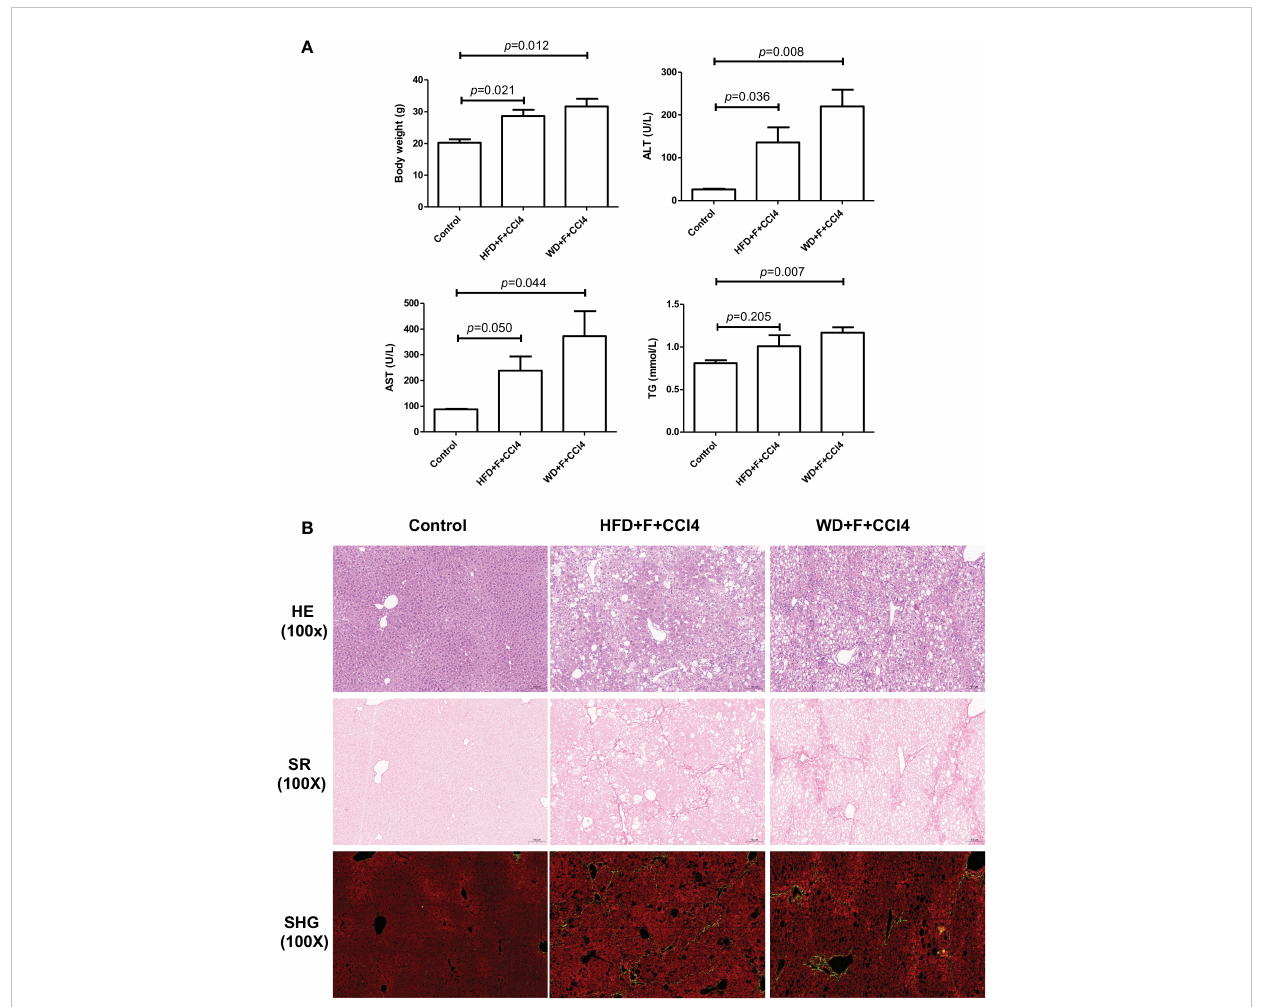
FIGURE 1 Metabolic and pathological characteristics of NASH mice with fi brosis. (A) Body weight, ALT, AST and TG levels and (B) Hematoxylin and eosin (H&E), Sirius Red staining and SHG/TPEF scanning images in control, HFD+F+CCl4 and WD+F+CCl4 mice. ps: ALT, alanine aminotransferase; AST, aspartate aminotransferase; and TG,